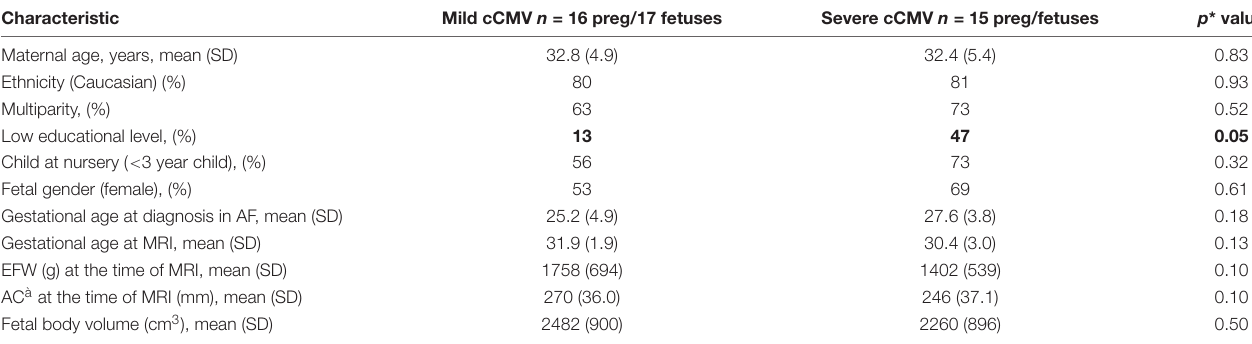
TABLE 2 | Baseline characteristics of pregnancies with congenital CMV infection according to the severity of brain abnormalities.